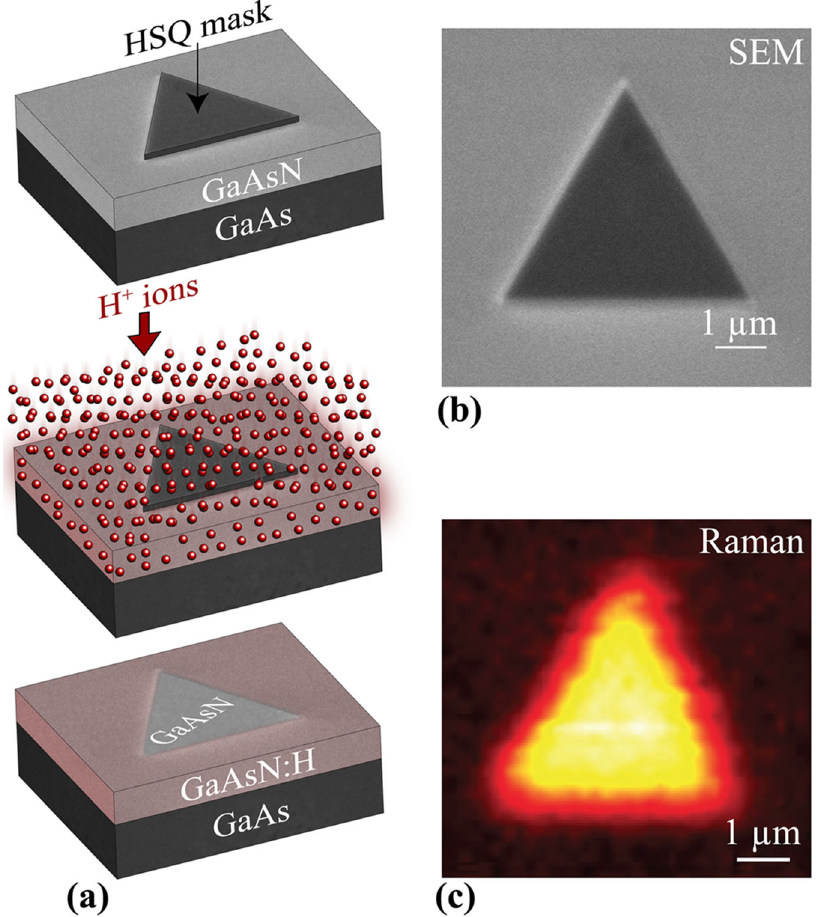
Fig. 1 Sketch of the HM-based fabrication process and pre-characterization. a Sketch of the micro-fabrication process described in the “ Methods ” section, based on the use of lithography-de fi ned hydrogen masks (HM) and H-ions irradiation: after removal of the mask a triangular GaAs 1 − y N y microstructure is left in the epilayer, surrounded by hydrogenated GaAs 1 − y N y regions of larger out-of-plane lattice parameter. b Scanning electron microscopy (SEM) image of the HM used in the process (an equilateral triangle of ~5 µ m side), prior to mask removal. c Micro-Raman color intensity map of the triangular GaAs 0.991 N 0.009 object fabricated as sketched in a